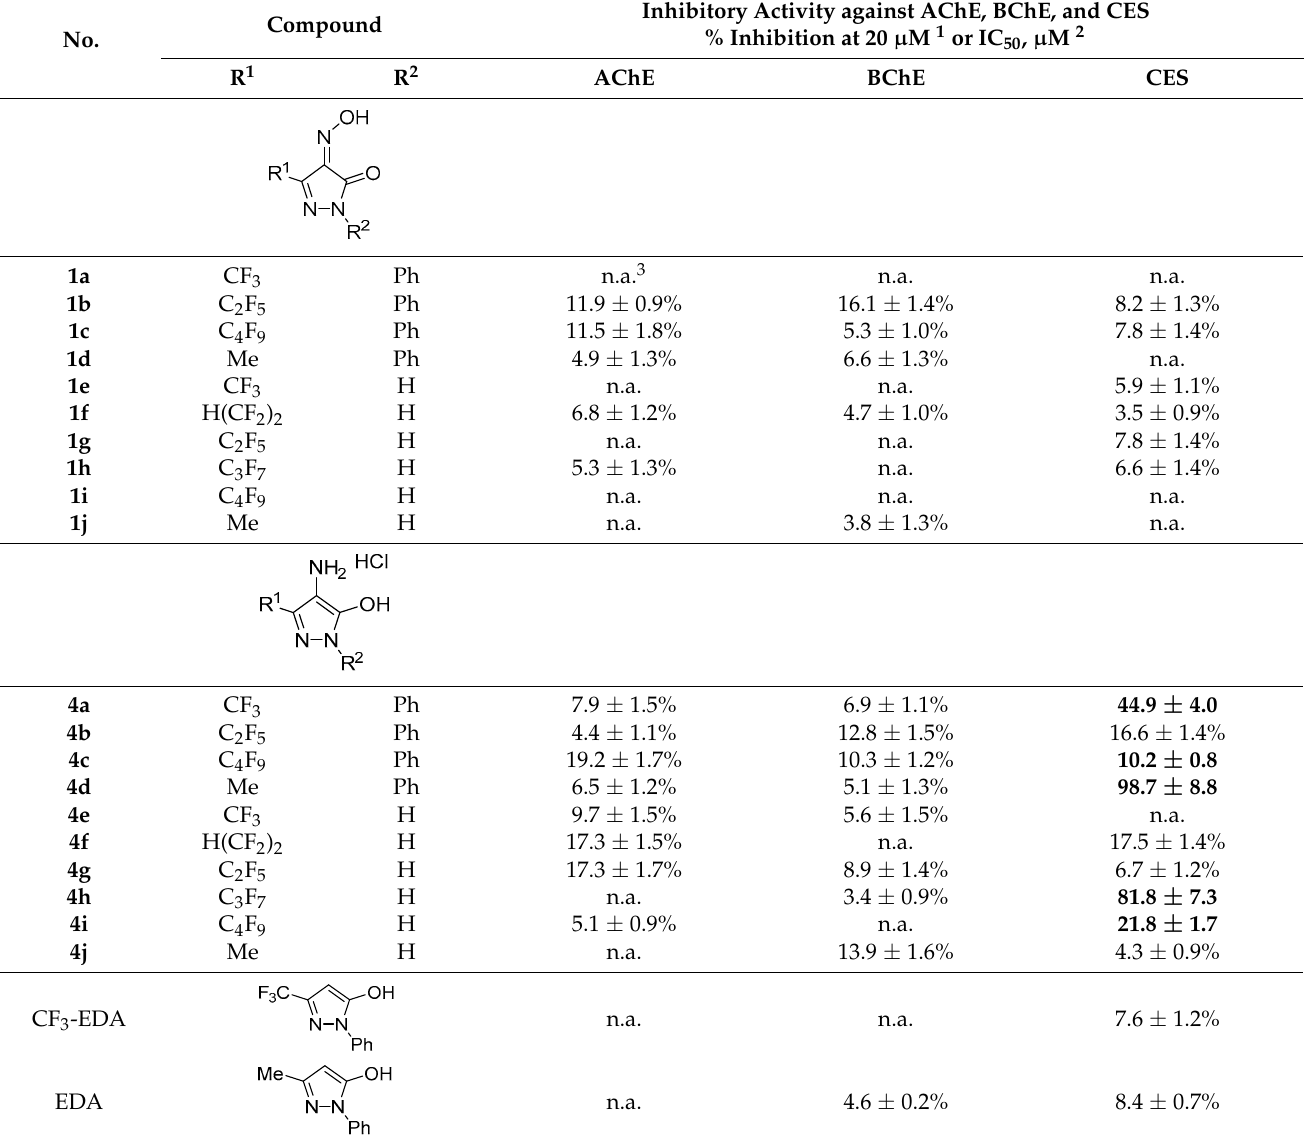
Table 2. Esterase profile of pyrazoles 1 and 4 .